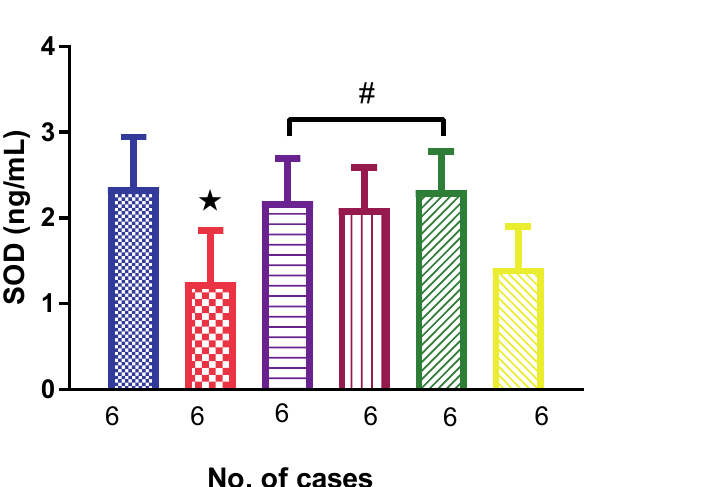
Figure 4. SOD activity in normal control (NC), prediabetic control (PD), metformin and diet intervention (MET + DI), metformin and high-fat/high-carbohydrate diet (MET + HFHC), rhenium (V) compound and diet intervention (Re + DI), and rhenium (V) compound and high-fat/high-carbohydrate diet (Re + HFHC) groups after 12 weeks of treatment. Values are presented as means ± SEM (n = 6). (cid:70) p < 0.05 in comparison with NC; # p < 0.05 in comparison with PD, MET +DI, MET + HFHC, Re + DI and Re + HFHC.